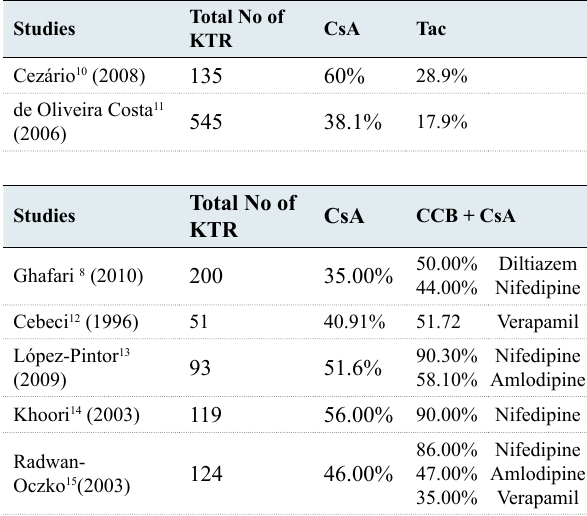
Number of Kidney Transplantations